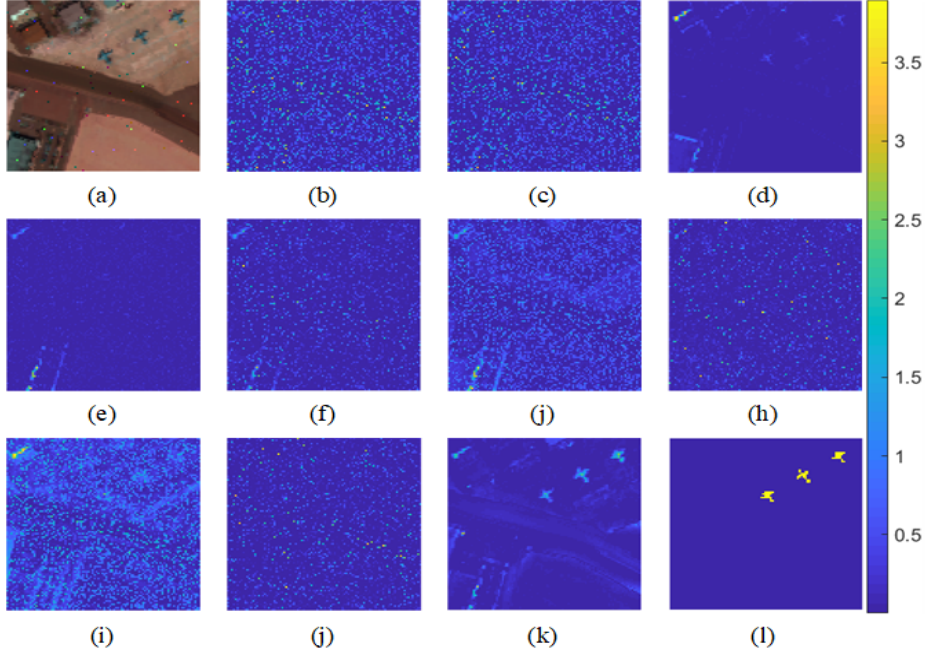
Figure 18. Detection results on the AVIRIS-I dataset with impulse noise (proportion): ( a ) Pseudo-color image; ( b ) RX; ( c ) RX-DWT; ( d ) RX-Kernel; ( e ) RPCA; ( f ) LSMAD; ( g ) LRASR; ( h ) FrFE; ( i ) GTVLRR; ( j ) FEBPAD; ( k ) proposed method; ( l ) ground